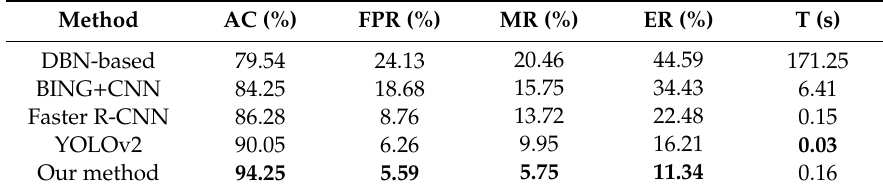
Table 3. Results comparison of di ff erent methods.